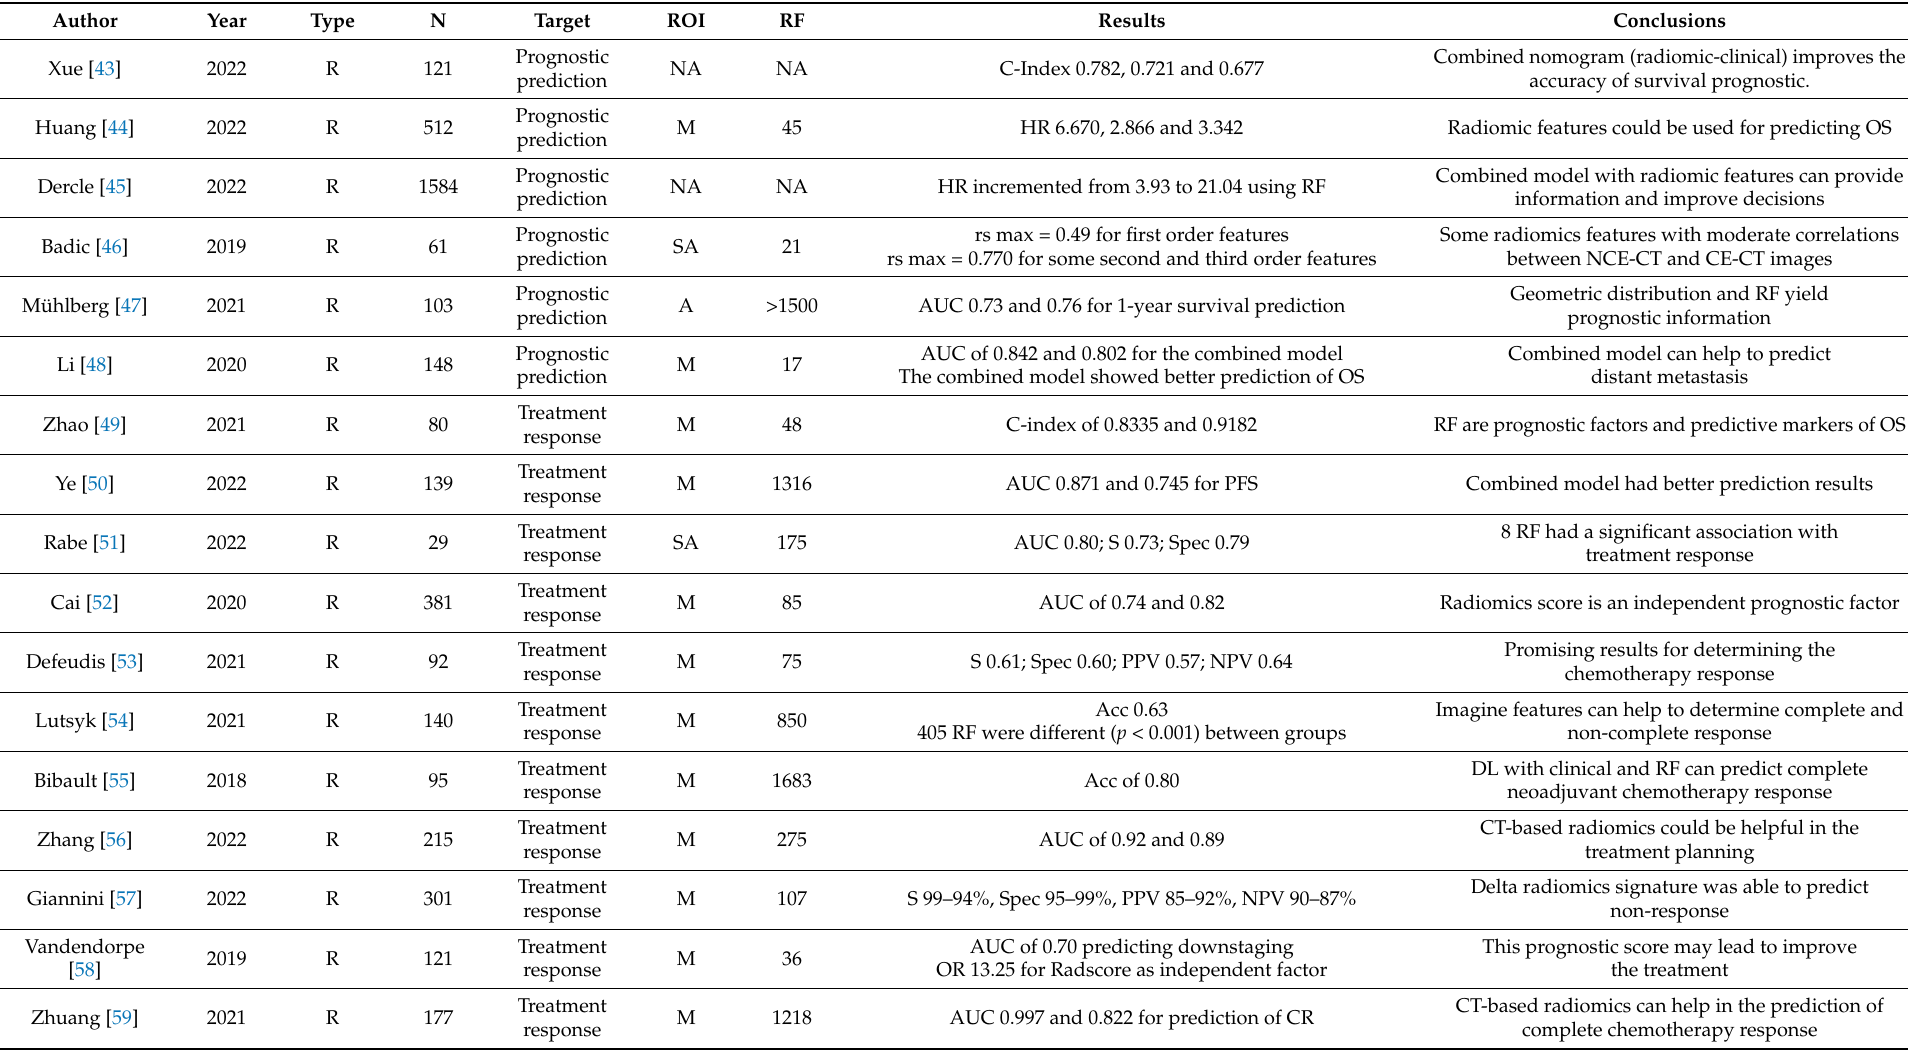
Table 2. CT-based Radiomics/Radiogenomics on